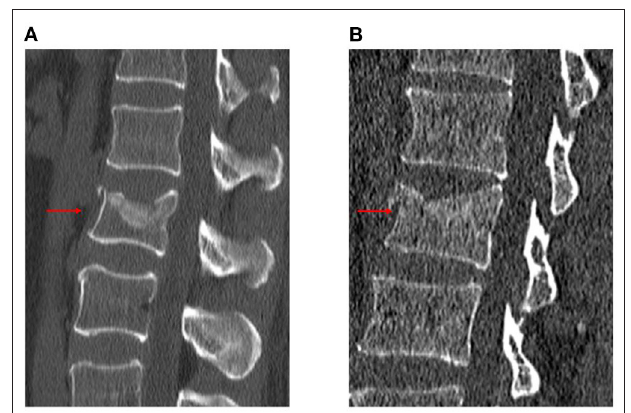
FIGURE 2 | Schematic diagram of fracture localization. Cranial endplate fracture (A) . Cranial endplate and anterior cortical wall fracture (B) .